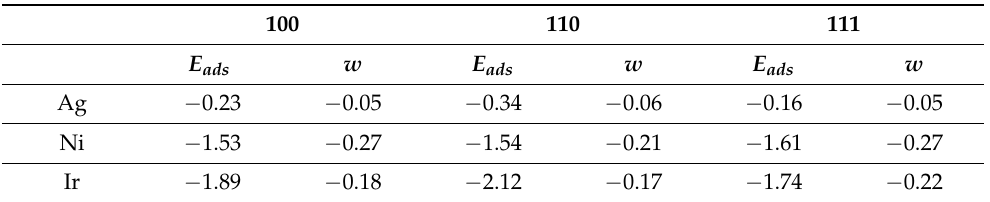
Table 2. Adsorption energy E ads (eV) of CO molecules on the three metals and the repulsion energy between the adsorbates w (eV) are presented. 100